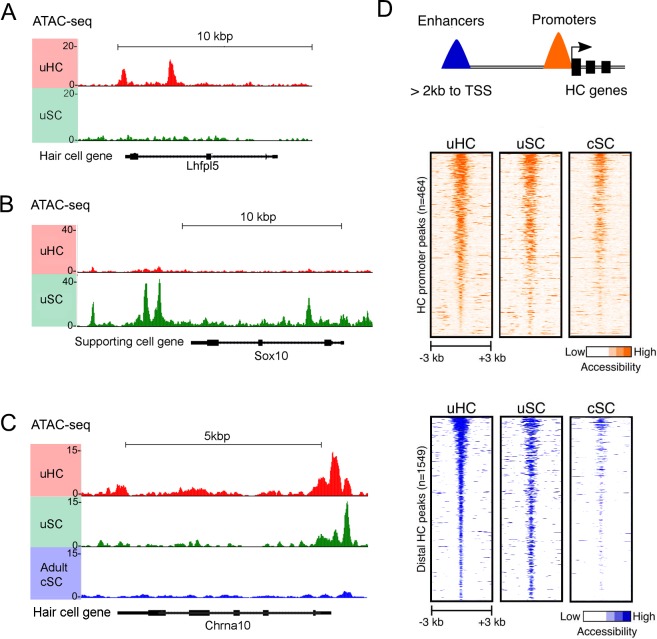
ATAC-seq analysis shows hair cell gene loci are more accessible in utricle supporting cells compared to cochlear supporting cells.(A) Example of ATAC-seq profiles for a hair cell-specific gene, Lhfpl5, that is not expressed in supporting cells. Peaks are present in the hair cell sample, but not the supporting cell sample B) Example of ATAC-seq profiles for a supporting cell-specific gene, Sox10, that is not expressed in hair cells. Peaks are present in the supporting cell sample, but not the hair cell sample. (C) Example of ATAC-seq profiles for a hair cell-specific gene, Chrna10, that is not expressed in supporting cells. A similar distribution of peaks is observed in utricle hair cells and supporting cells, but the peaks are absent in P21 cochlear supporting cells. (D) A heat map showing the correlation of ATAC-seq signals from utricle hair cells, supporting cells and P21 cochlear supporting cells. Peaks were grouped on the basis of their proximity to the transcriptional start site (TSS) or grouped as occurring in distal enhancers if they were located >2 kb away from the annotated TSS. Top, ATAC-seq signal (read depth) across putative hair cell gene promoters (n = 1549). High read intensity is shown in orange. Bottom, ATAC-seq signal (read depth) at more distal hair cell gene enhancers (n = 464). High read intensity is shown in blue.